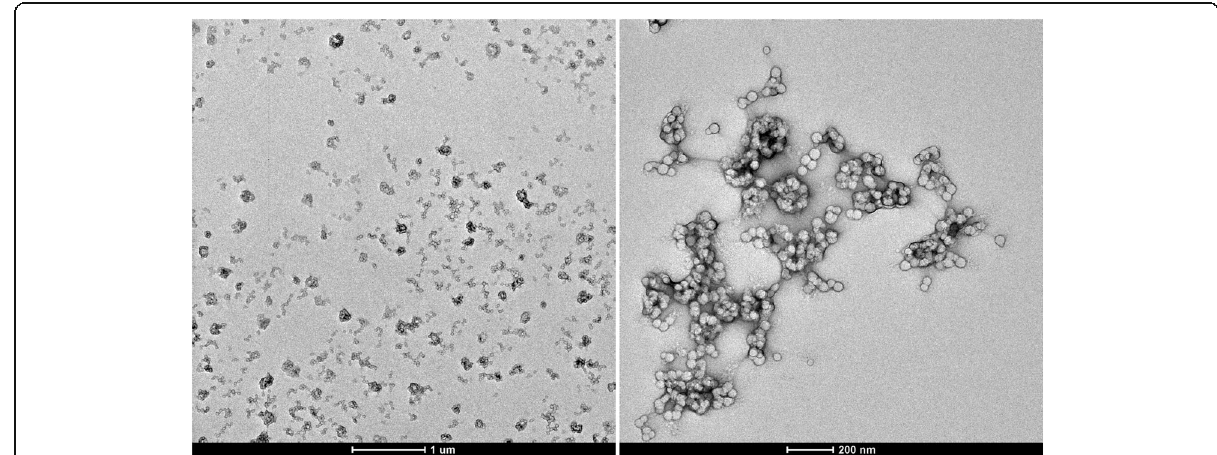
Fig. 2 TEM images of the obtained PS-PPO-PNIPAM hybrid nanosystems with lower (left) and higher (right) magnification